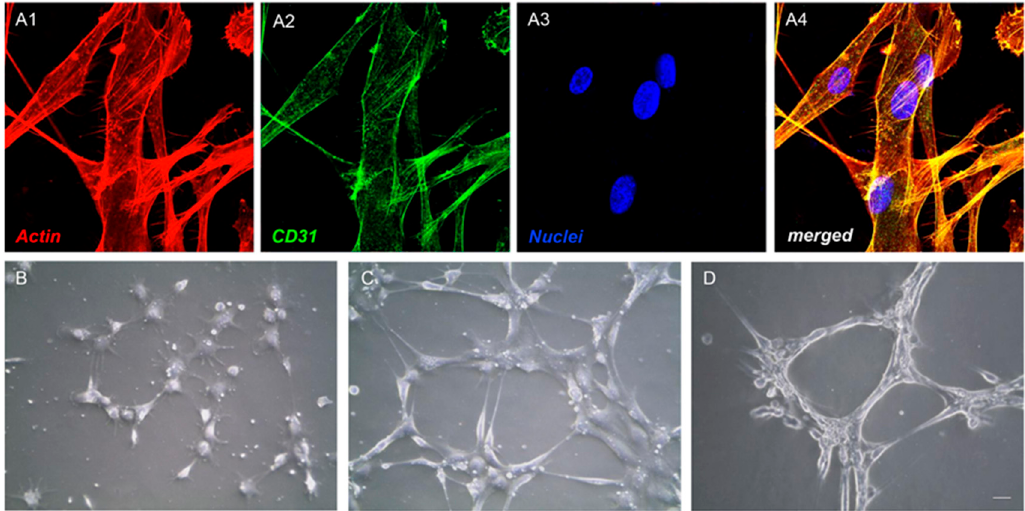
Figure 2. Endothelial differentiation and tube formation of hGMSCs. ( A1 – A4 ) After 14 days of exposure to endothelial differentiation, endothelial differentiated- human Gingival Mesenchymal Stem Cells (e-hGMSCs) showed positivity for endothelial marker, CD31. ( B – D ) After culture under endothelial differentiation conditions for 24 h, hGMSCs were seeded onto Cultrex to allow the formation of capillary-like structures. Cells were observed by means light microscopy after 2 (h) ( B ), 4 h ( C ) and 6 h ( D ) after seeding on dishes pre-treated with Cultrex. ( A1 – A4 ): magnification, 40 × ; ( B – D ): scale bar, 20 µ m.